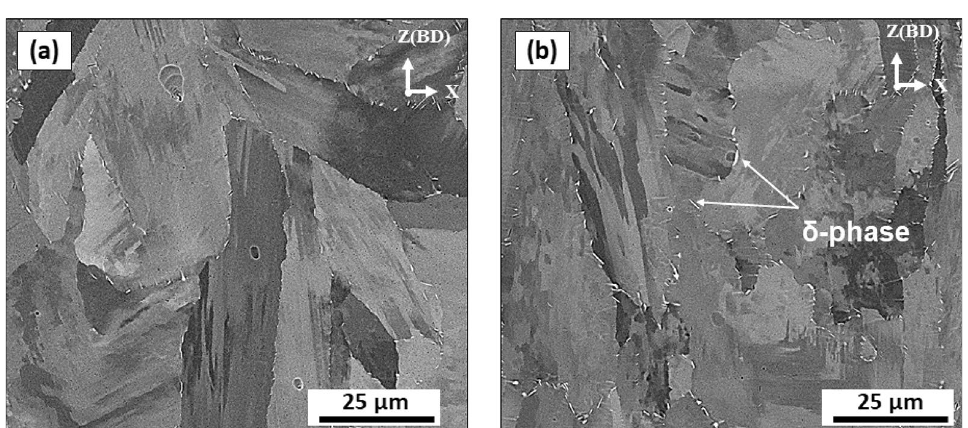
Figure 7. SEM micrograph of a non-etched LPBF IN718 illustrating the presence of δ-phase precipitated for heat treatment conditions: ( a ) HSA1; ( b )